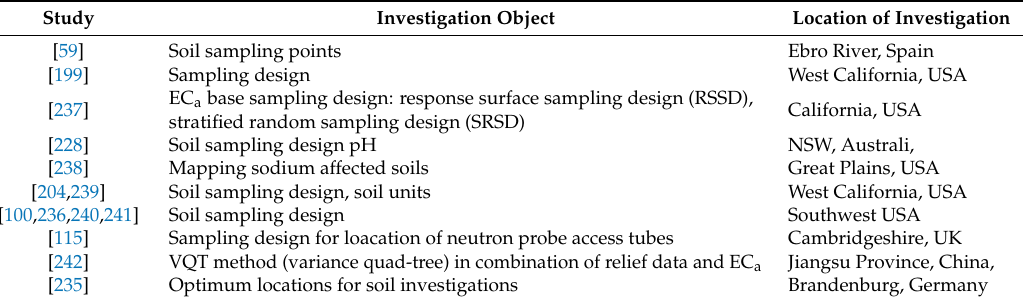
Table 5. Literature describing selection of areas for soil sampling with EM38-EC a